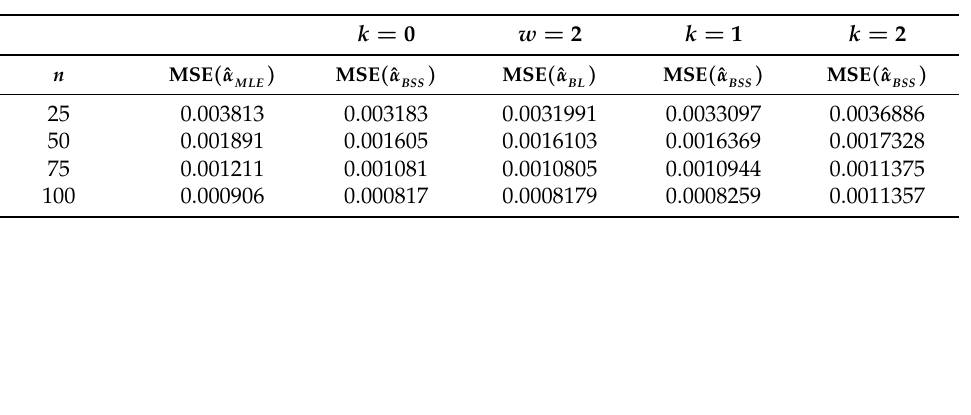
Table A2. Simulated MSE of ˆ α using Uniform b over [0, 1], β = 1.5, u = 4 and v =